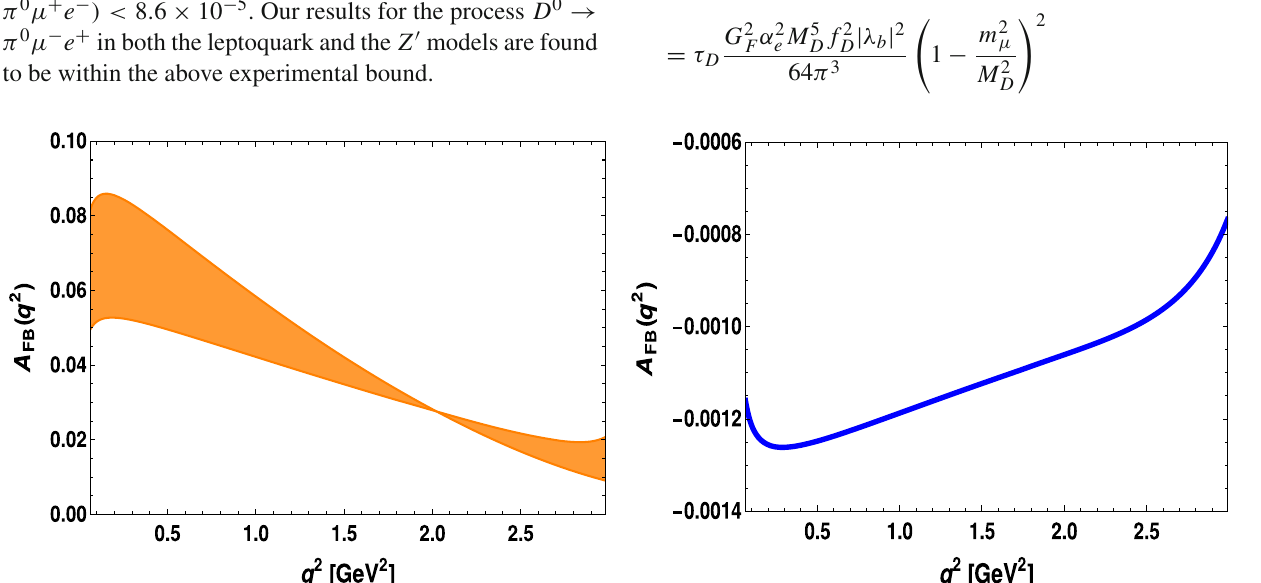
Fig. 7 The variation of forward–backward asymmetry of the LFV process D + → π + μ − e + in the leptoquark model ( left panel ) and generic Z (cid:2) model ( right panel ) with respect to q